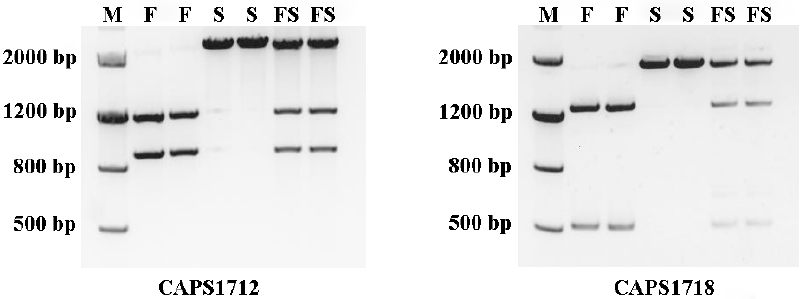
Figure 5. The CAPS markers of Glyma.09G171200 and Glyma.09G171800 co-segregated with Rf3 . M, marker; F, restorer line; S, cytoplasmic male sterile line; FS, semi-fertile F 2 plants. For CAPS1718, after amplification and digestion by BspEI restriction endonuclease, the CAPS1718 marker also produced different bands in fertile, sterile, and semi-fertile plants. Two fragments, one located between the 500 and 800 bp loci and the other located between the 1200 and 2000 bp loci, were considered homozygous at the restorer-of-fertility gene locus ( Rf3Rf3 ), indicating fertile plants. A single band on 2000 bp loci was considered homozygous but lacked the restorer-of-fertility gene allele ( rf3rf3 ), indicating sterile plants. Three fragments were considered heterozygous at the restorer-of-fertility gene locus ( Rf3rf3 ), indicating semi-fertile plants (Figure